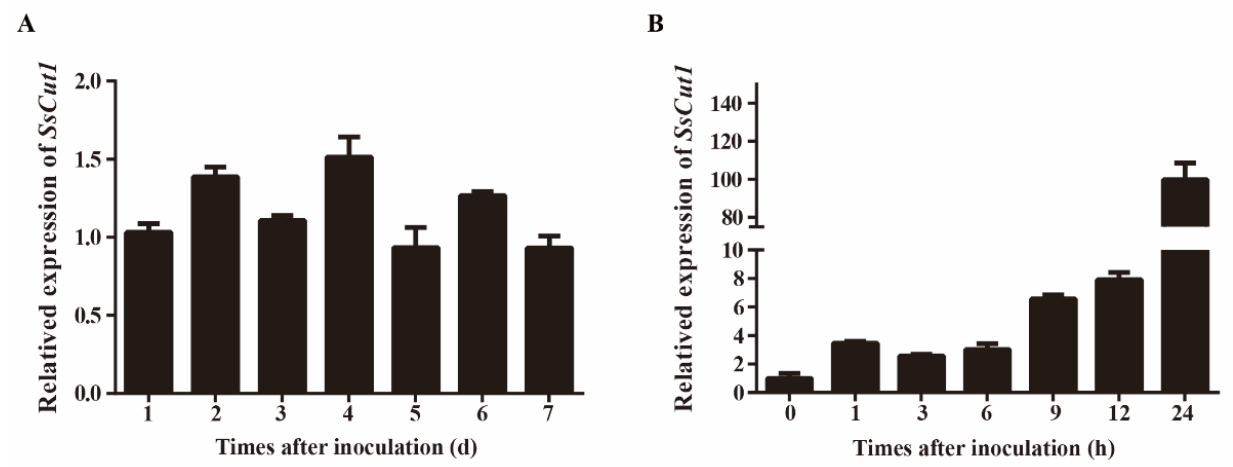
Figure 2. Expression patterns of SsCut1 of S. sclerotiorum at different stages of S. sclerotiorum . ( A ) Expression patterns of the SsCut1 in culture on PDA medium at 20 ◦ C for 1–7 d (days). ( B ) Expression patterns of the SsCut1 during the infection of A. thaliana at 20 ◦ C for 0–24 h (hours). The S. sclerotiorum β -tubulin gene was used as an internal control to normalize the data. Error bars represent the standard error ( n = 3).